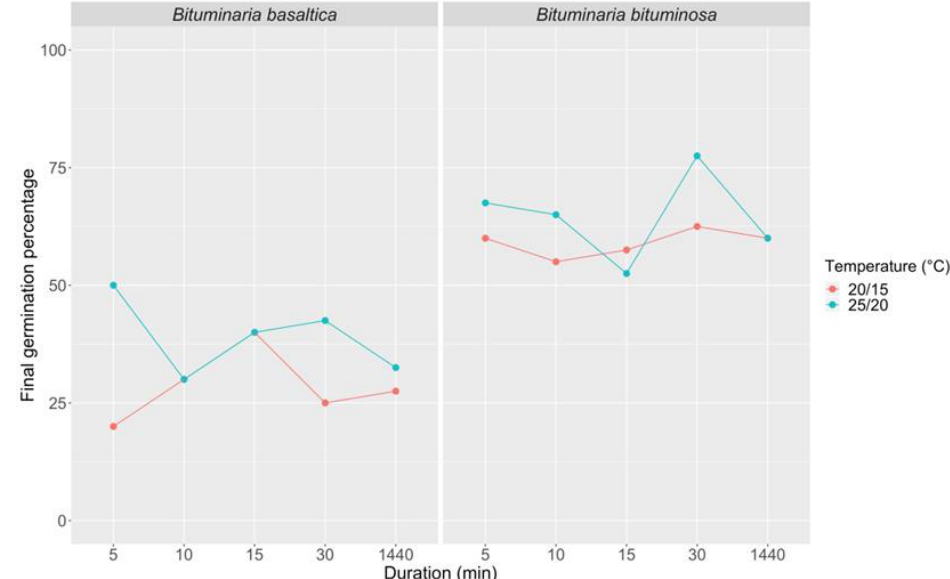
Figure 6. Final germination percentage at 20/15 and 25/20 °C incubation temperatures in B. basaltica and B. bituminosa after different immersion times (5, 10, 15, 30, 1440 min treatment duration) in boiling water gradually cooling up to room temperature.